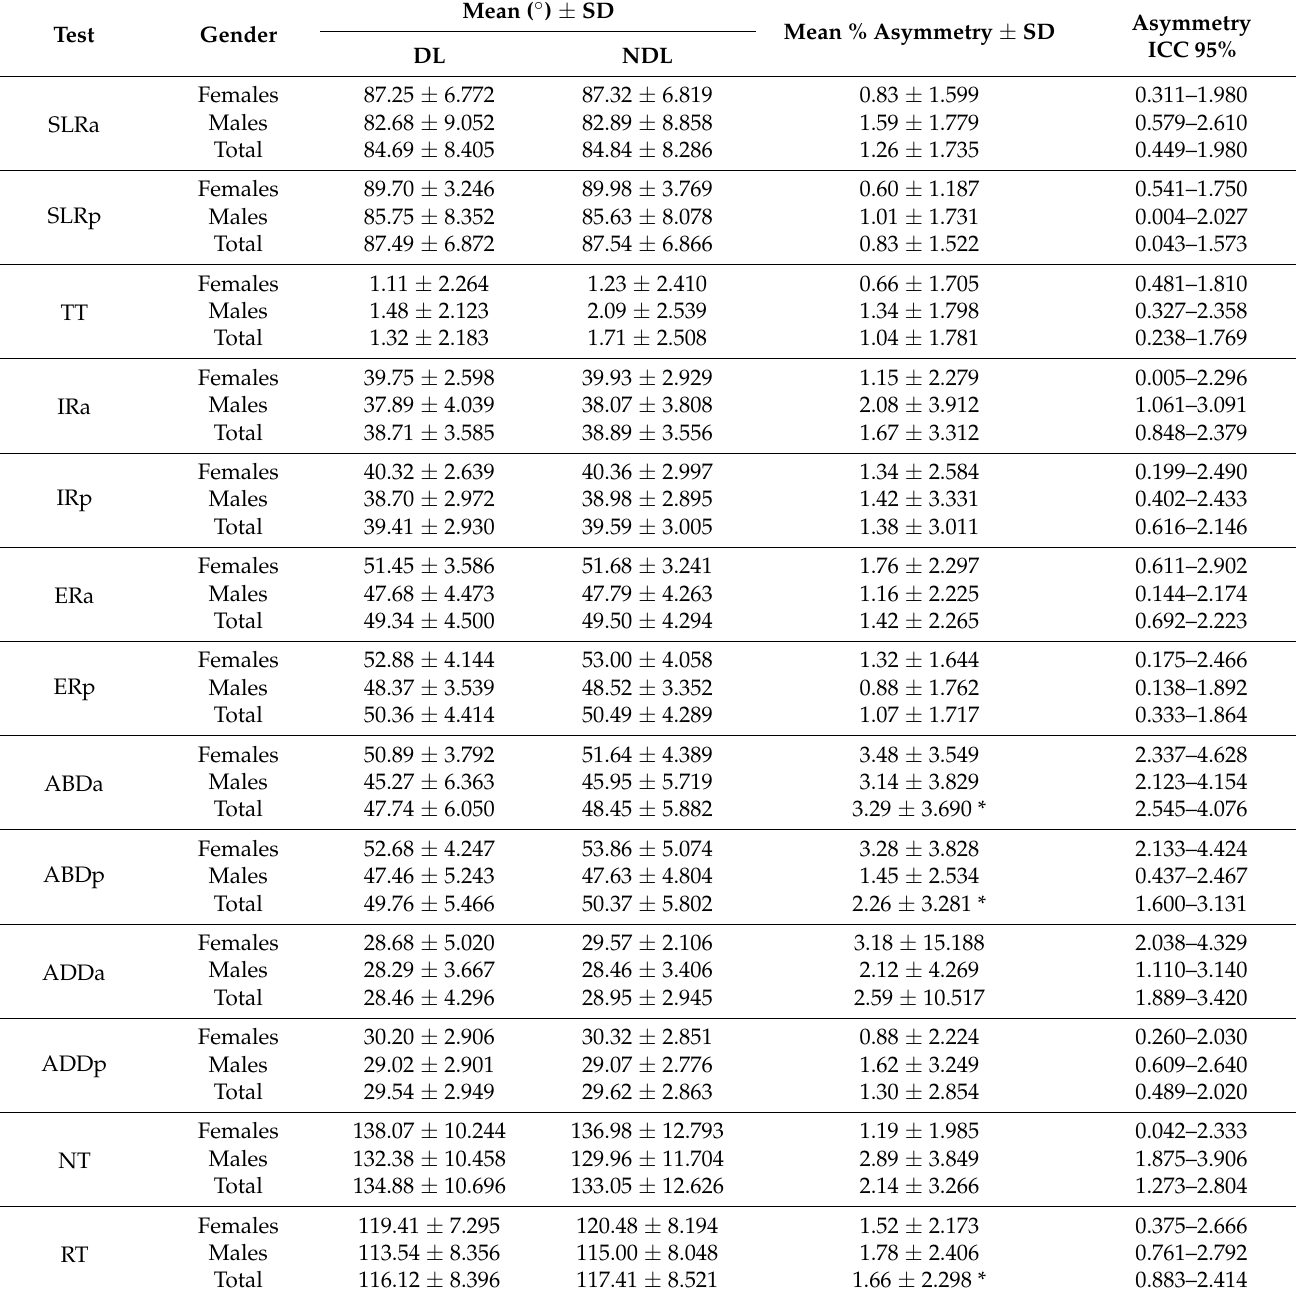
Table 1. Descriptive statistics of ROM tests and the magnitude of interlimb asymmetry for each